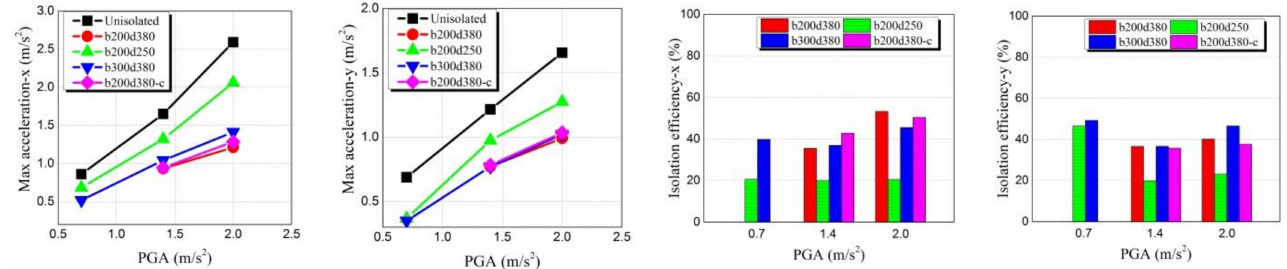
Figure 27. The maximum acceleration responses and isolation efficiency under ChiChi-TCU122 (low-frequency) ground motion.